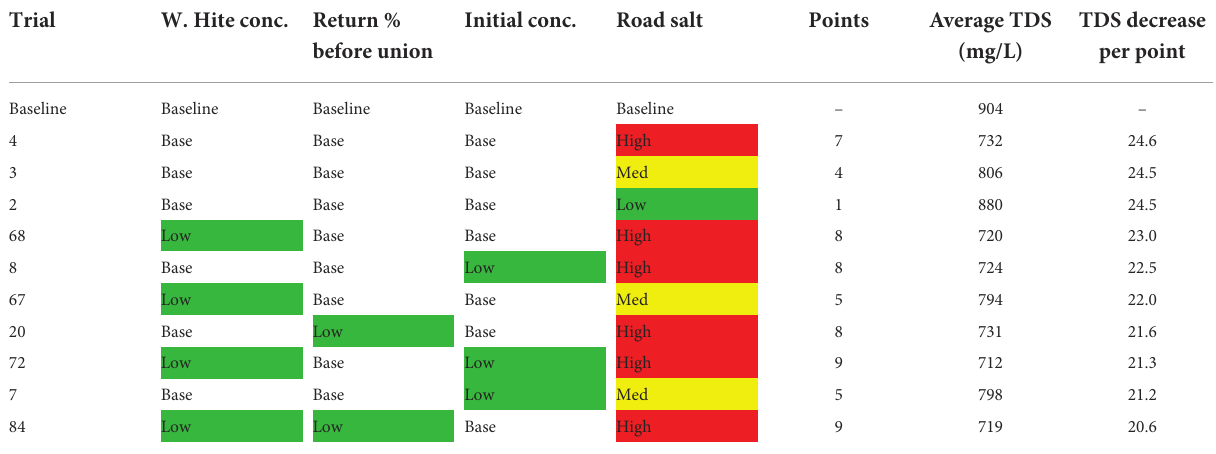
TABLE 2 Top 10 efficient urban salt management trials for the months November–March.